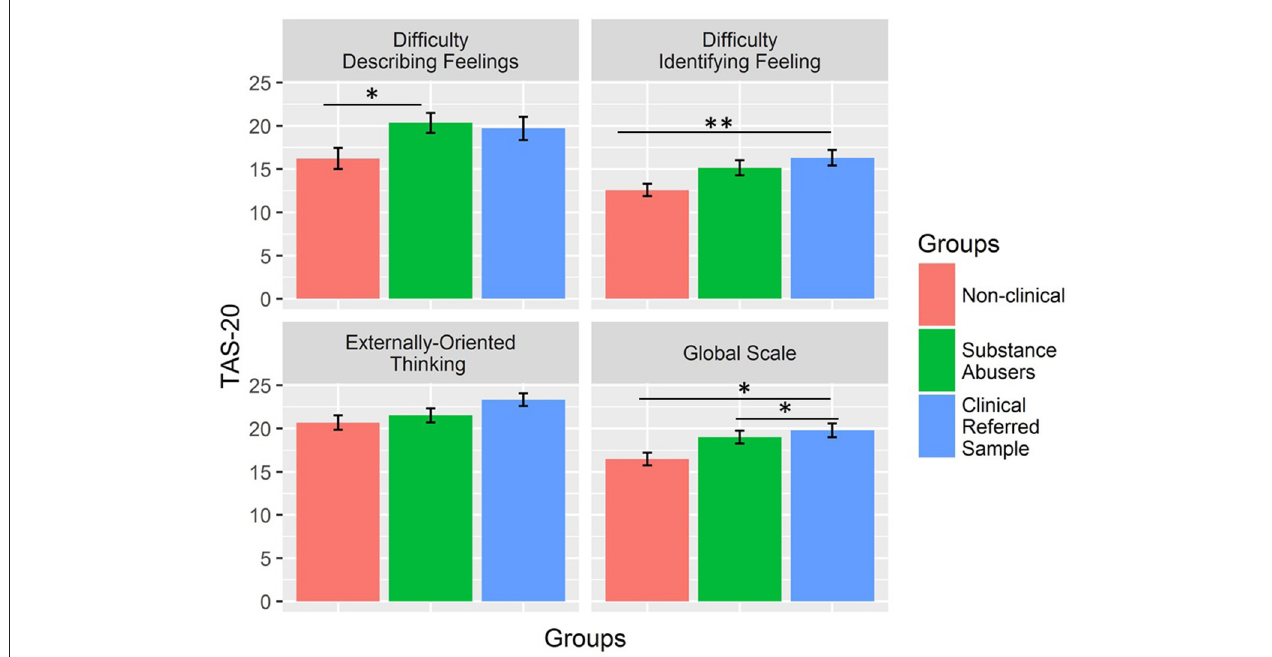
FIGURE 1 | TAS-20 differences between groups.* p < 0.05; ** p < 0.01.